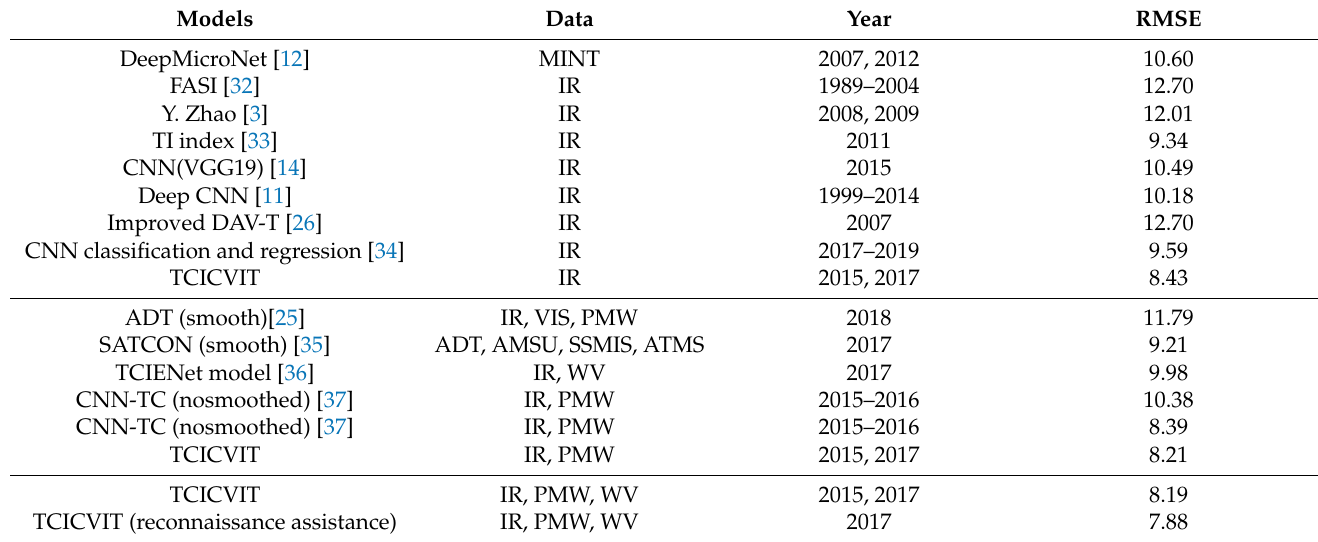
Table 9. Comparison of RMSE and MAE for TC intensity estimation for TCDBNet and other satellite- based models. Performance metrics are directly taken from the